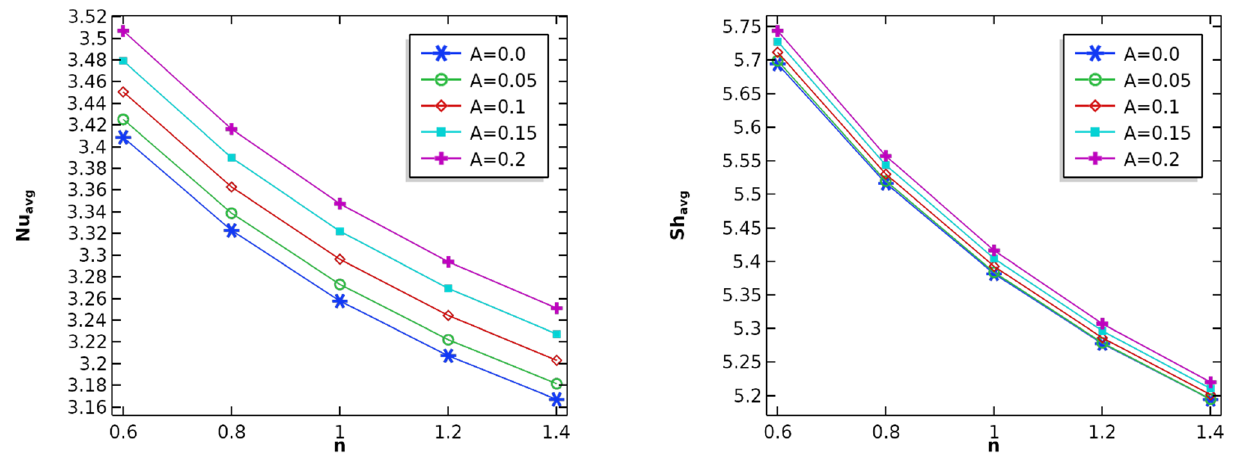
Figure 16. Impact of average Nu and Sh .